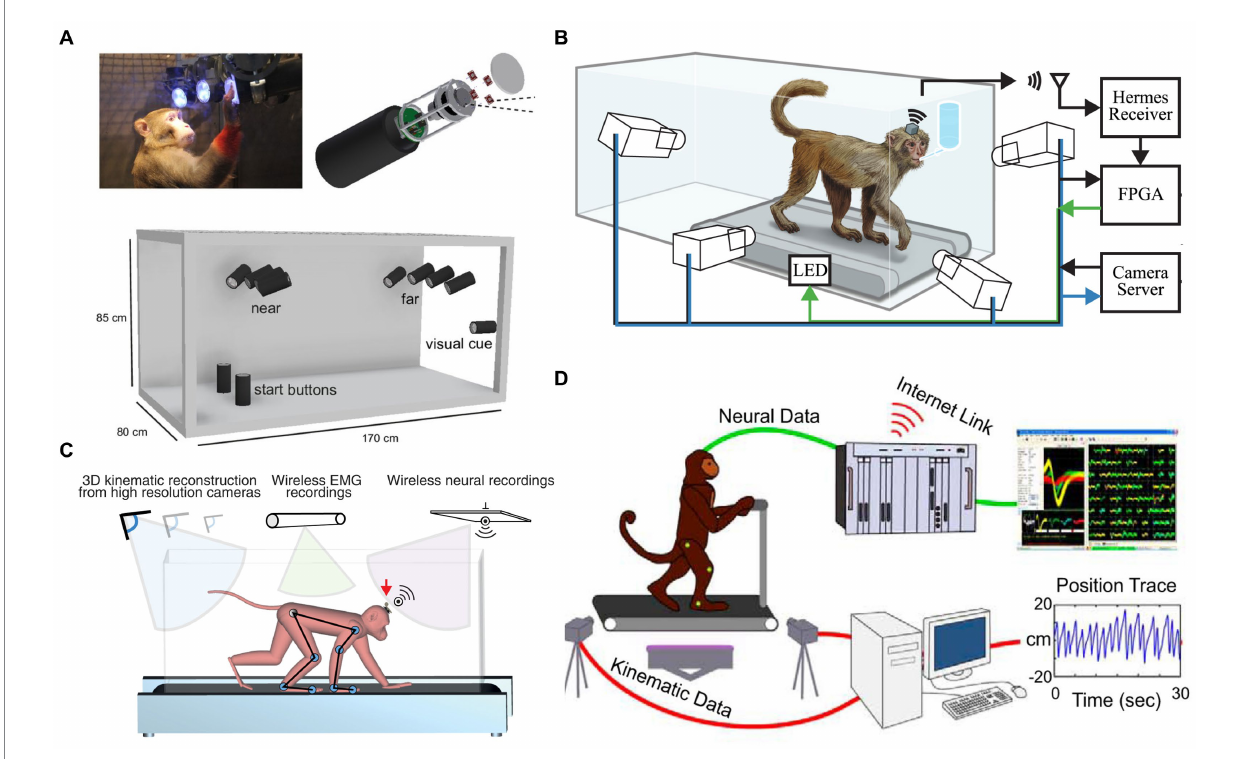
FIGURE 1 Freely-moving NHP models. (A) An unconstrained NHP in the Reach Cage [Reproduced with permission from Berger et al., 2020]. (B) Treadmill NHP model [Reproduced with permission from Foster et al., 2014]. (C) An unconstrained NHP on a treadmill [Reproduced with permission from Yin et al., 2014]. (D) Bipedal walking NHP model [Reproduced with permission from Lebedev and Nicolelis,